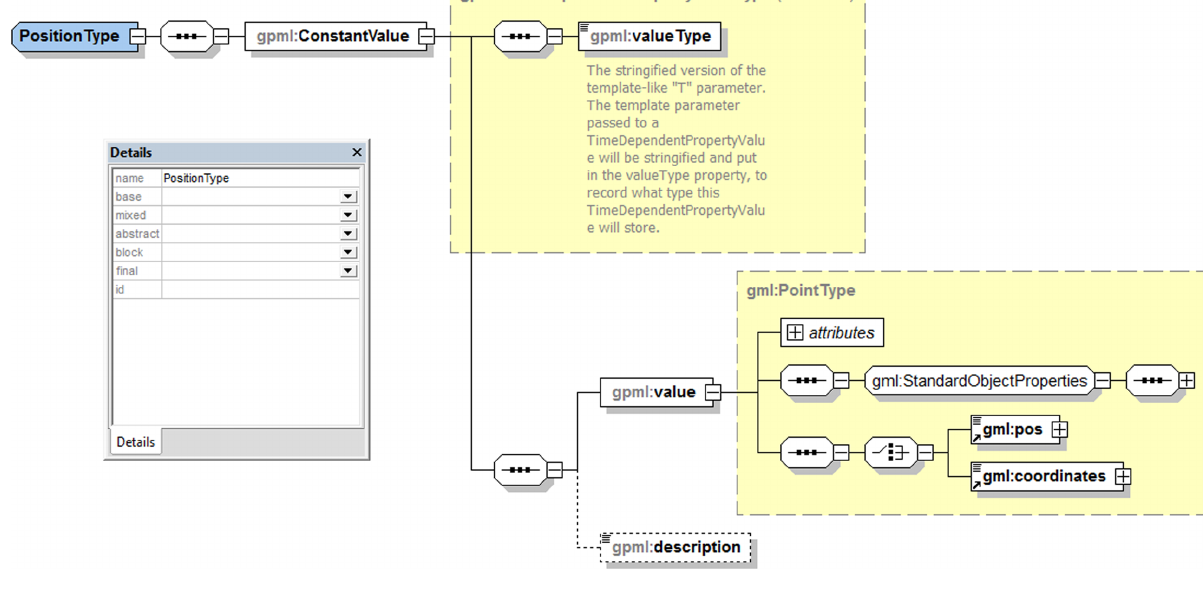
Fig. 20. The position schema diagram in GPML.